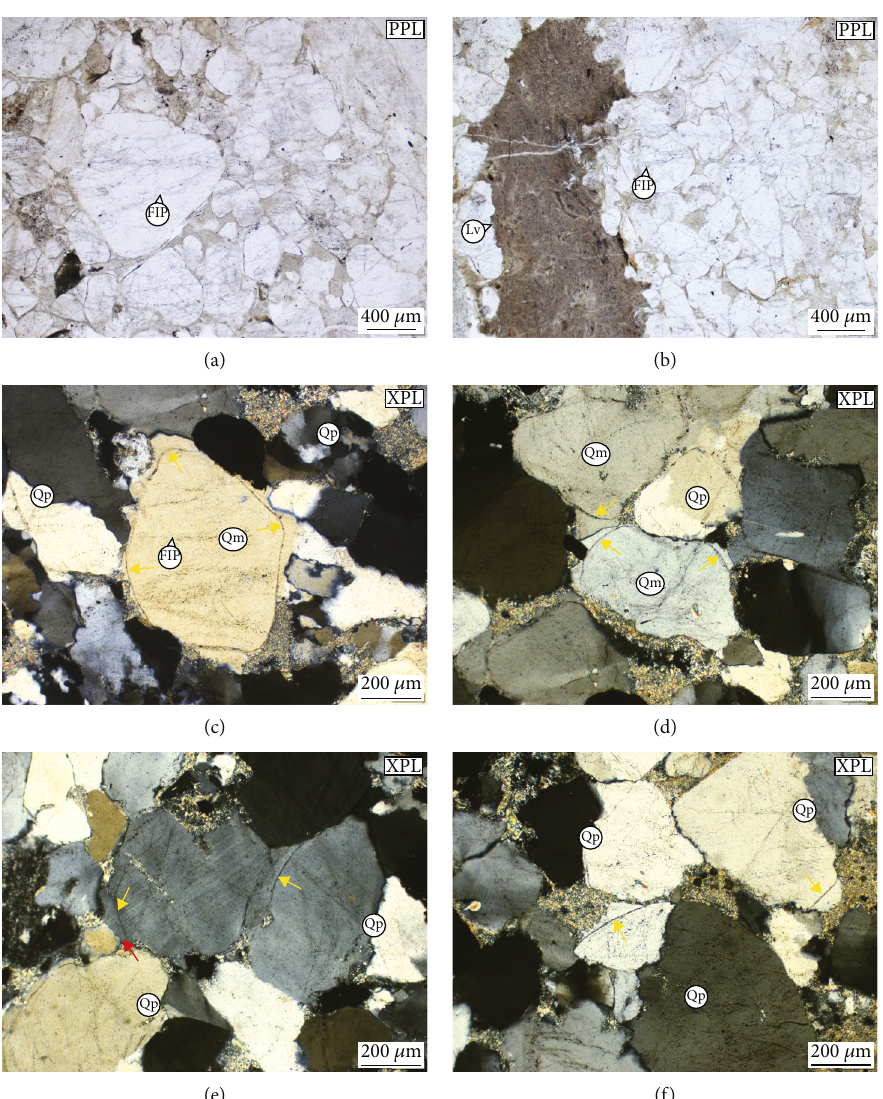
Figure 10: Thin-section photomicrographs of the Triassic sandstone clasts separated from the Lower Miocene conglomerate ((a – d, f) well Ás – É – 4 core #3; (e) well Ás – É – 9 core #2). (a, b) Sets of parallel transgranular microcracks marked by fl uid inclusion plains together with tiny quartz veinlets (see volcanic lithic grain). (c – f) Rounded framework grains with syntaxial quartz overgrowths. Notice that the yellow arrows show the original grain boundary. Marginal parts of the detrital quartz grains and/or overgrowth cement are partially replaced by microcrystalline silica. Note: deformation lamellae in both the original quartz grain and its overgrowth (red arrow), re fl ecting that the lamellae developed after cementation. Abbreviations: PPL: plane-polarized light; XPL: cross-polarized light; FIP: fl uid inclusion plain; Lv: volcanic lithic fragment; Qm: monocrystalline quartz; Qp: polycrystalline